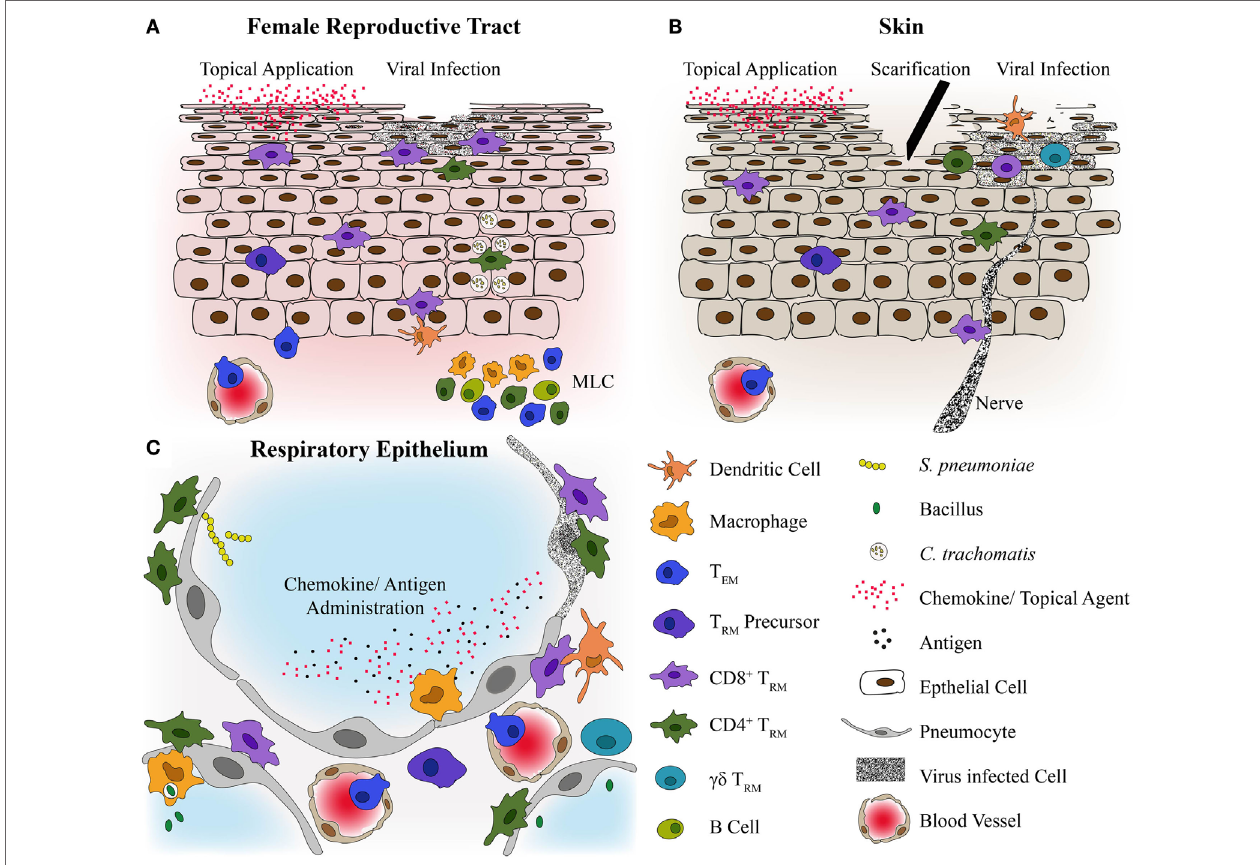
FiguRe 3 | Visual summary of key T RM effector responses and vaccine strategies at epithelial surfaces. (a) Represents the female reproductive tract. Topical application of both specific chemokines and general inflammatory agents such as nonoxynol-9 can be used to “pull” systemically primed T EM into the mucosal tissue. CD103 + T RM reside closer toward the apical surface of the mucosa. Both CD4 + and CD8 + T RM play a role in controlling viral infections. Memory lymphocyte clusters have been shown to be important in controlling infections at this site. CD8 + T RM re-stimulation appears to be dependent on CD301b + dendritic cells that reside in the lamina propria. (B) Represent the integumentary epithelium. Topical application of both specific chemokines and general inflammatory agents such as 2,4-dinitroflourobenzene can be used to “pull” systemically primed T EM into the epidermal tissue. Skin scarification as a route of vaccination encourages the development of skin T RM . Upon antigen recognition, skin T RM lose their dendricity and become less motile. γδ T RM can mediate early immune responses. CD8 + αα + T RM have been found in the dermal–epidermal junction where they may be able to survey local neural tissue for reactivation of latent viral infections. (c) Represents the respiratory epithelium. While different chemokines have shown the ability to “pull” T RM into the respiratory epithelium and airways, the presence of antigen appears to be important at this site. T RM -mediated control of Streptococcus pneumoniae is largely dependent on the CD4 + subset. Control of viral and Mycobacterium tuberculosis infection requires both CD4 + and CD8 + T RM . γδ T RM , in conjunction with CD4 + T RM have been shown to mediate immunity against Bordetella pertussis